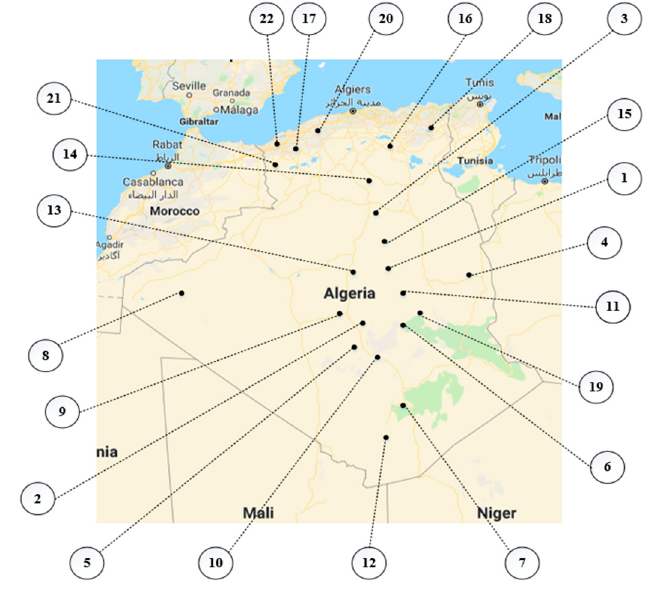
Figure 17. Locations of PV stations in Algeria.